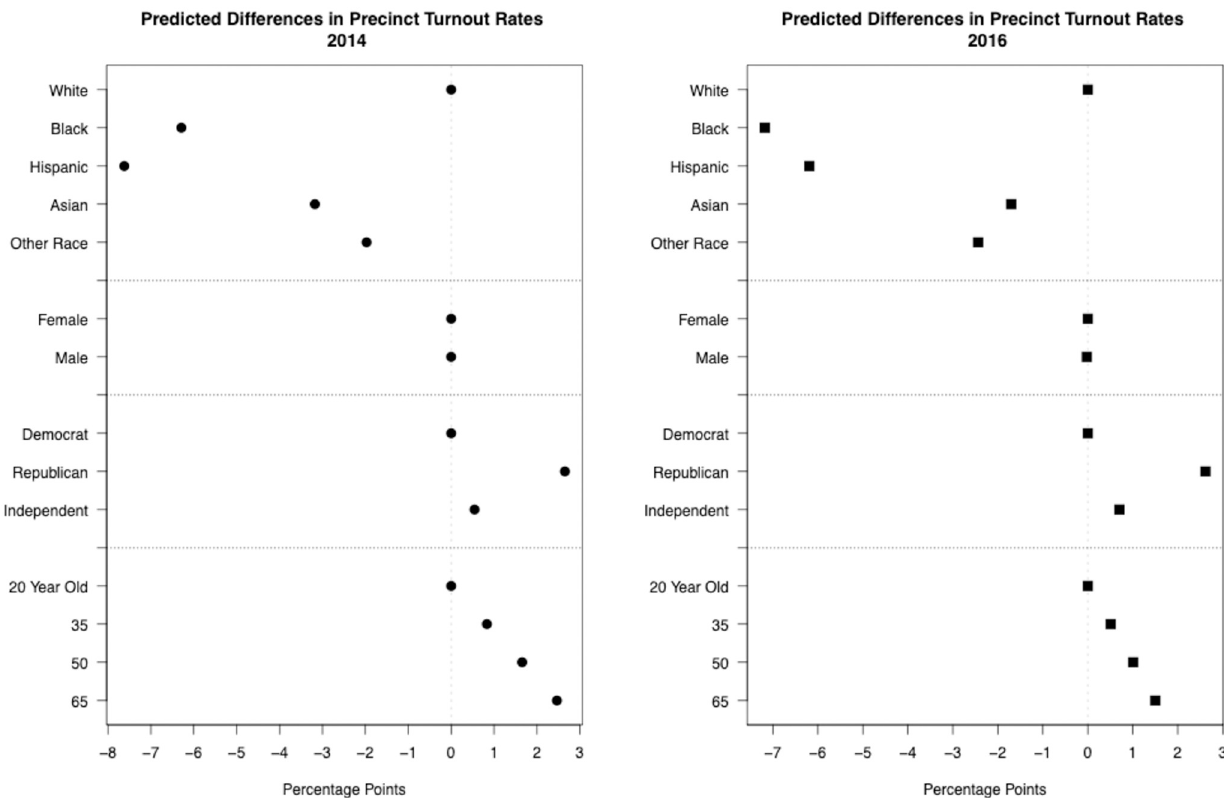
Fig 5. Regression results predicting precinct turnout rate each figure shows coefficients from a model where a voter’s precinct turnout rate is the dependent variable. Coefficients show predicted differences in turnout rates for various demographic characteristics of voters. In both 2014 and 2016 Black and Hispanic voters lived in precincts where turnout was between 7 and 8 percentage points lower than white voters. In both years Republicans lived in precincts where turnout was approximately 3 percentage points higher than Democratic voters. Each model includes state fixed effects and standard errors are clustered by precinct. Confidence intervals are not shown because the very large sample size (150–200 million in each model) leads to intervals that are incredibly small.